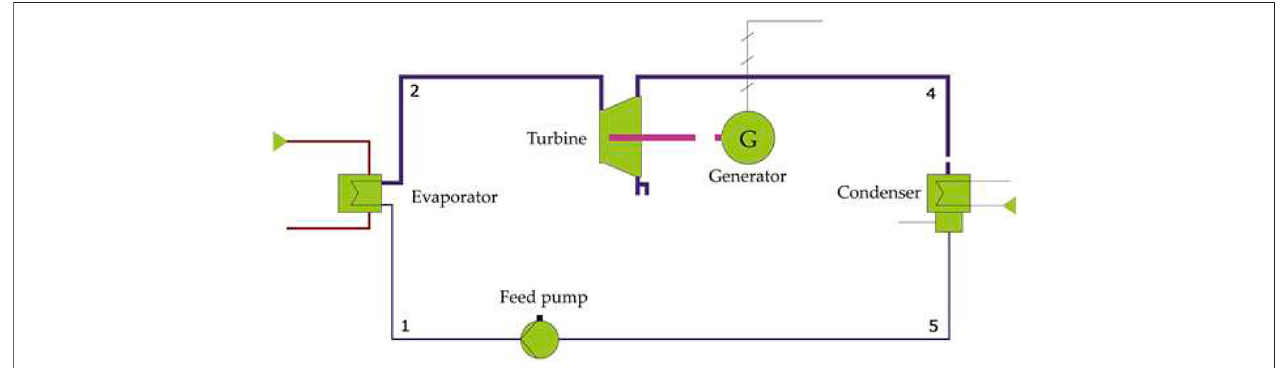
FIGURE 1 | Schematic of a simple ORC (Javanshir et al.,